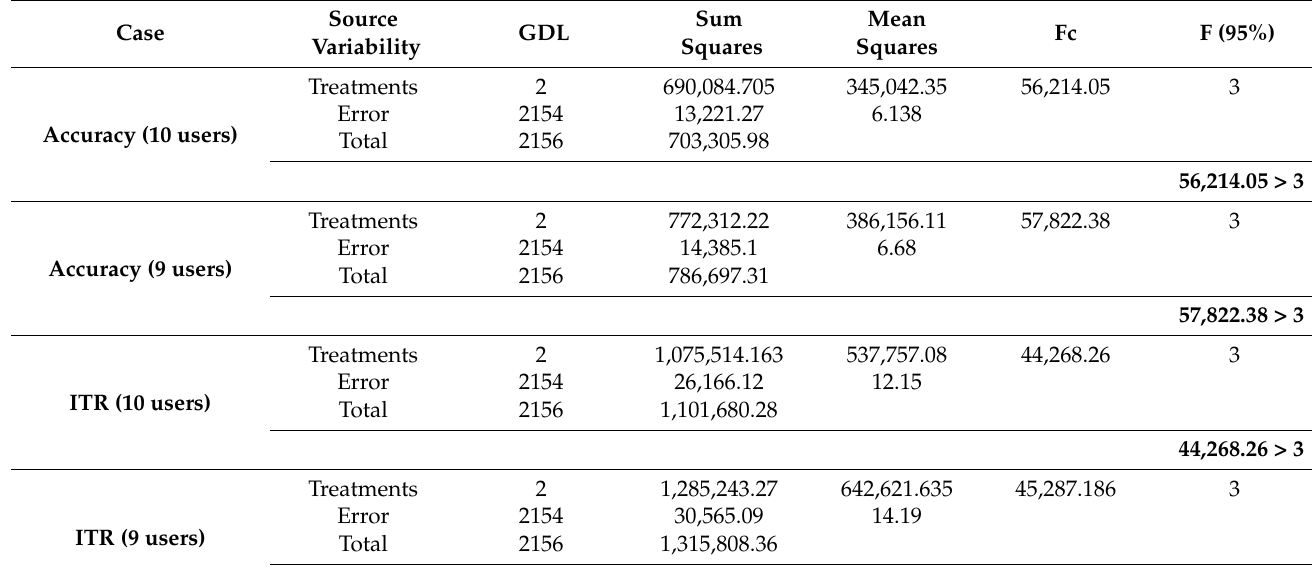
Table 3. Analysis of Variance (ANOVA).